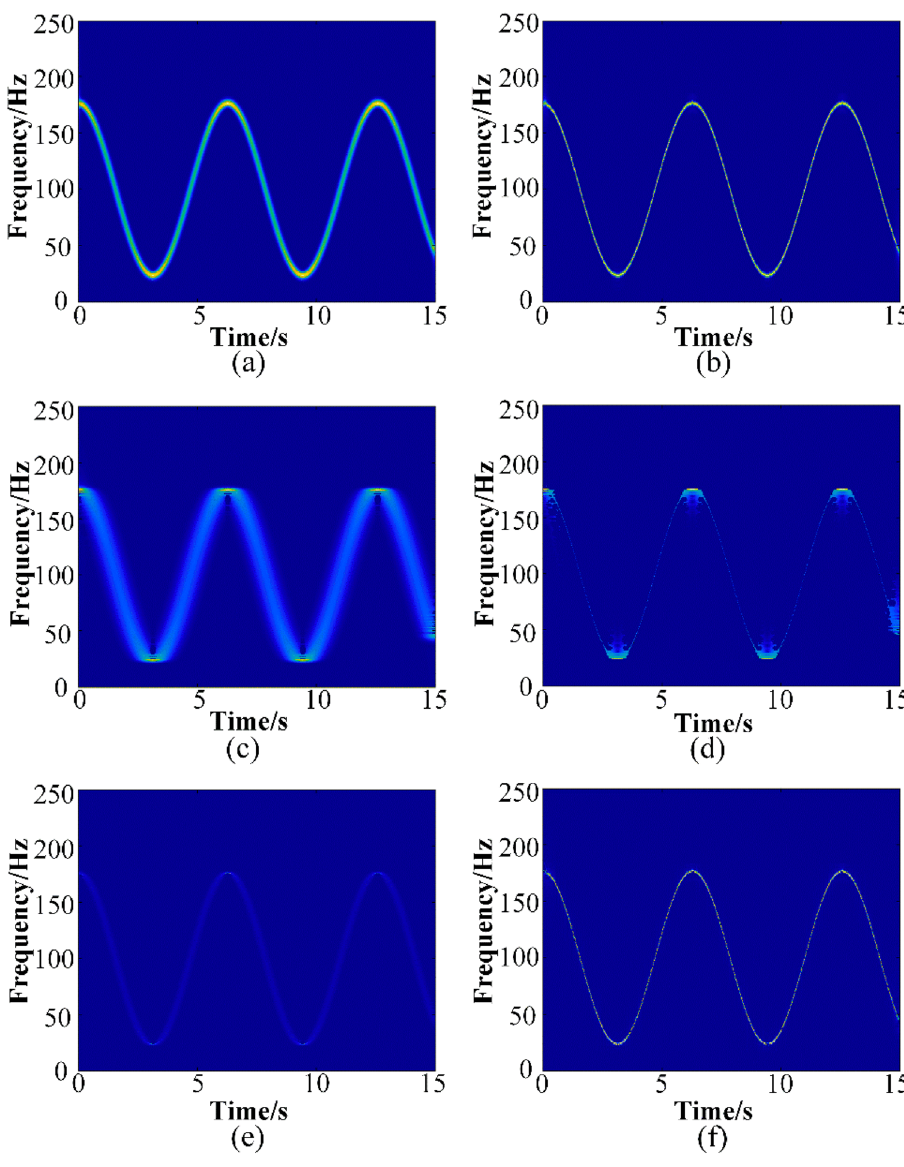
Figure 2. The TFRs obtained by ( a ) STFT, ( b ) GWT, ( c ) SET, ( d ) SSET, ( e ) SST, ( f )